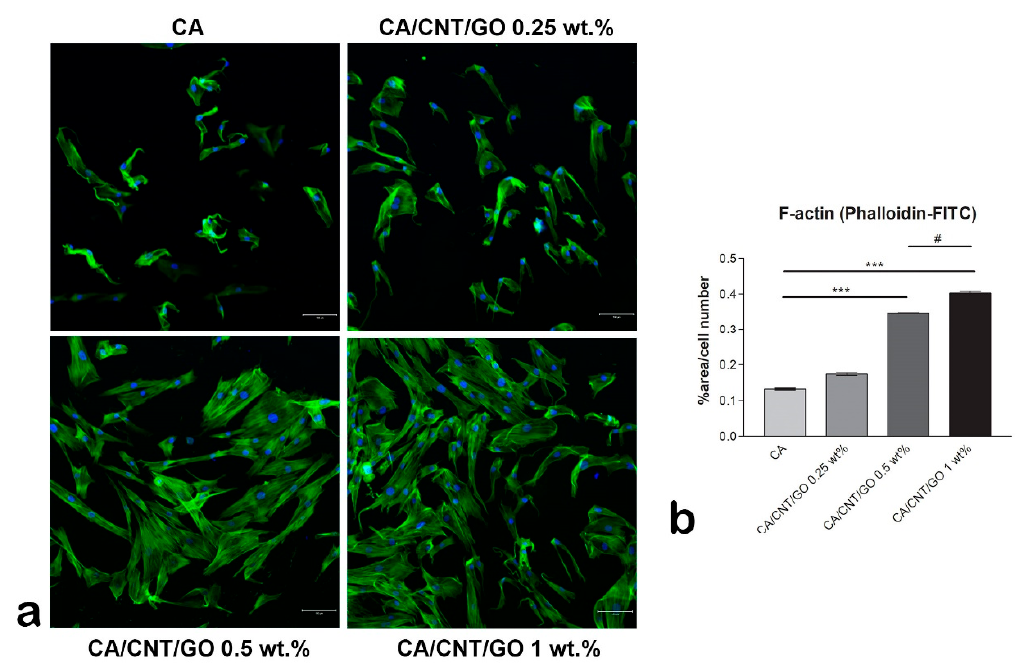
Figure 3. Cytoskeleton developed by human adipose-derived stem cells (hASCs) cultivated in contact with CA-CNT-GO materials, scale bar 100 µ m. ( a ) Fluorescence images of the actin filaments (green) and nuclei (blue) of hASCs and ( b ) quantification of the phalloidin-FITC staining normalized to cell number. Statistical significance: # p < 0.05; *** p < 0.001.